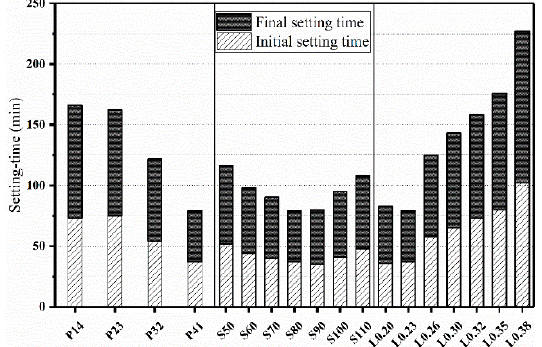
Figure 5. Effects of precursor composition, dosage of solid powdered sodium silicate and liquid–solid ratio on se tt ing time.